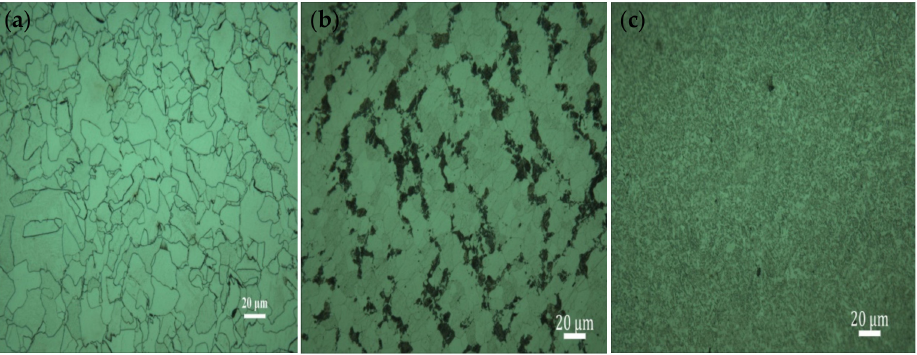
Figure 1. Microstructure images of the samples cooled in furnace ( a ), air ( b ) and water ( c